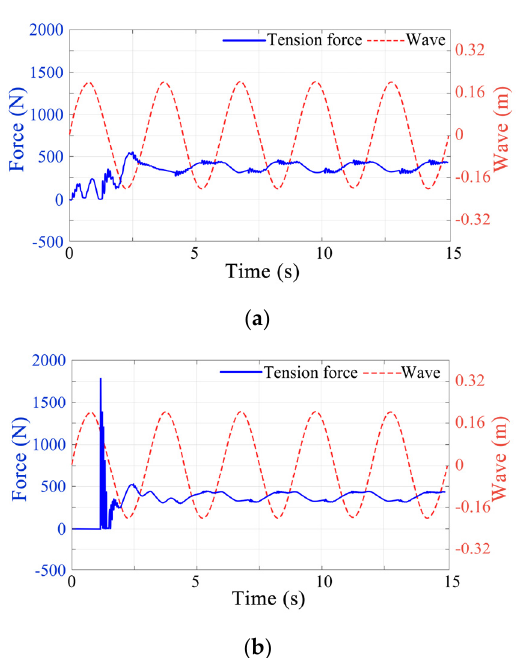
Figure 10. Tension force of the hinged joint between cable and float ( a ) Method 1 and ( b ) Method 2.